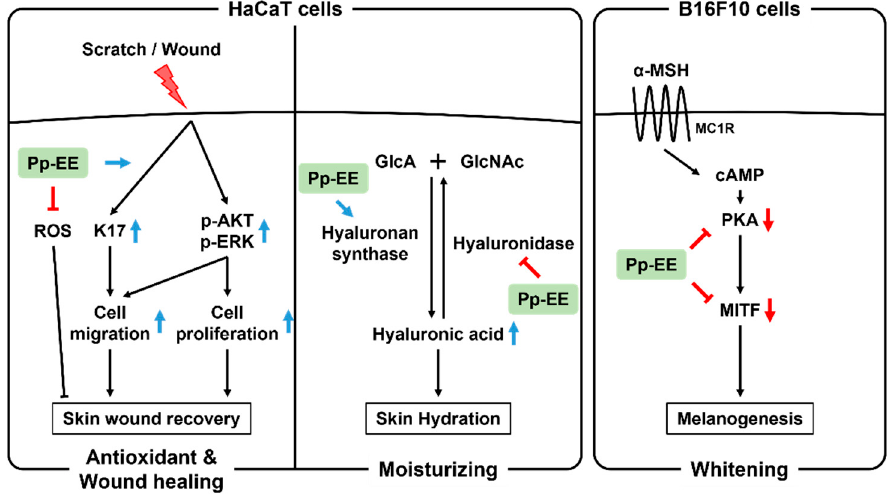
Figure 6. Schematic representation showing the skin moisturizing, whitening, and wound-healing effects and antioxidant capacity of Pp-EE.